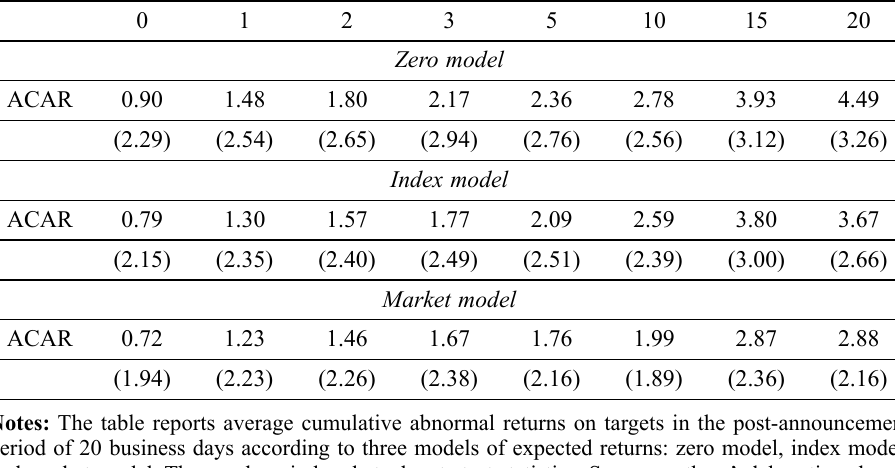
Table 2. Short-term abnormal returns on target companies